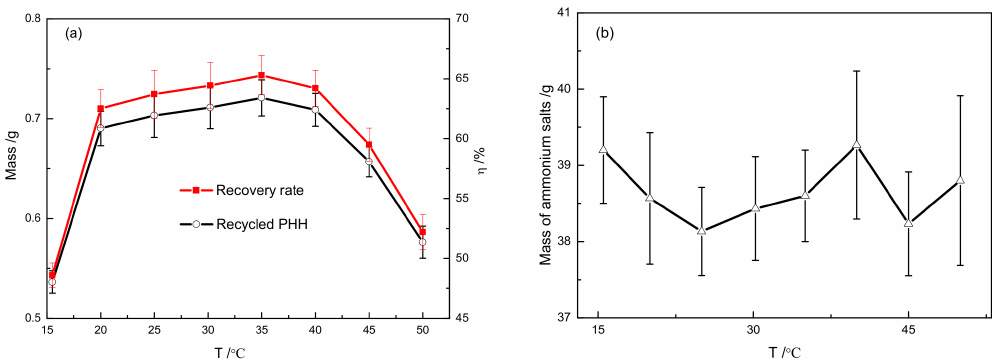
Figure 3. Effects of the temperature on the mass of recycled PHH and recovery rate η ( a ), as well as mass of recycled ammonium salts ( b ) with solvent ratio 1 at pH = 9.2.